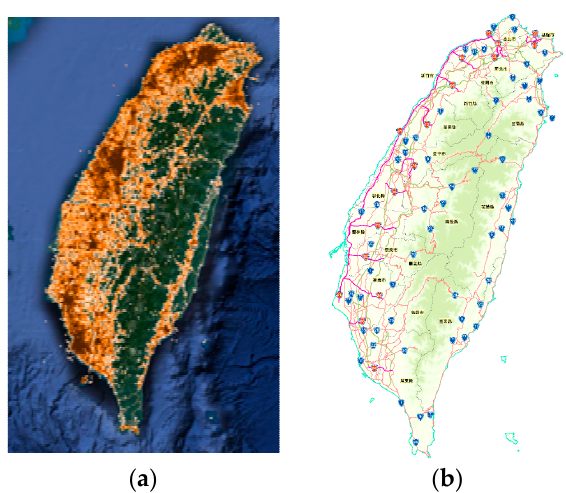
Figure 7. ( a ) Distribution of spots and ( b ) distribution of highways. The layout of ( a ), respectively, coincides with the layout of ( b ) and the layout of Figure 4a.